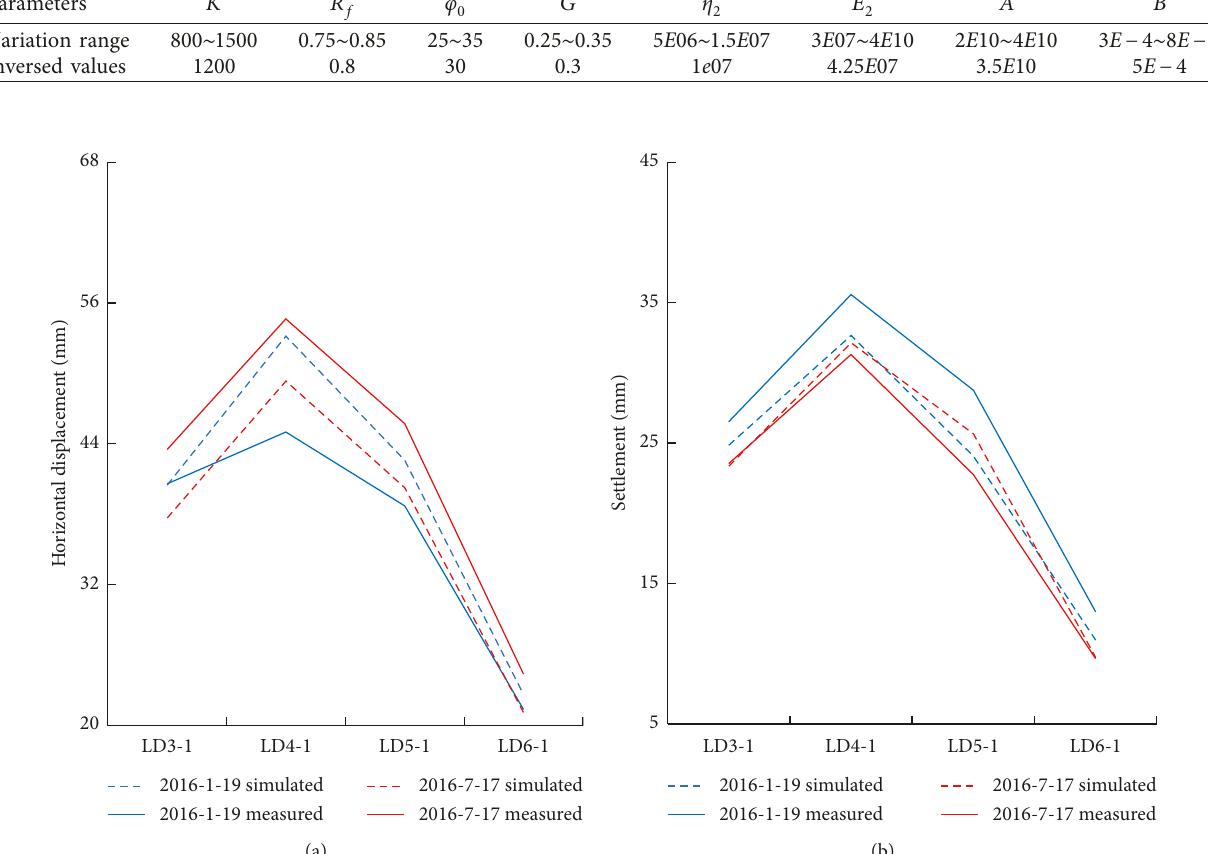
Figure 12: Displacements of gauging points LD2-1 to LD6-1